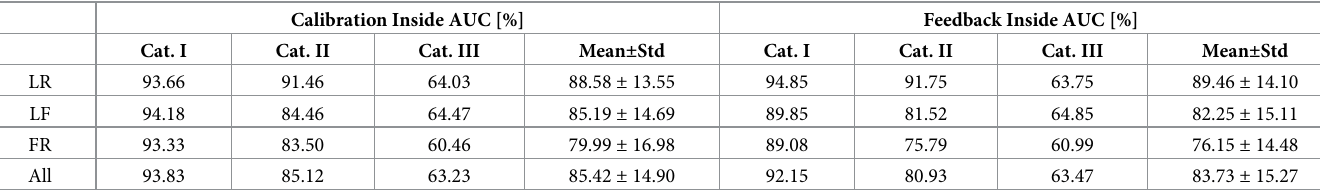
Inside accuracy (calculated by LOO-CV on each run) of calibration and feedback data averaged by user category and class combination. The mean values across runs of the AUC is reported. The last row shows the average across all class